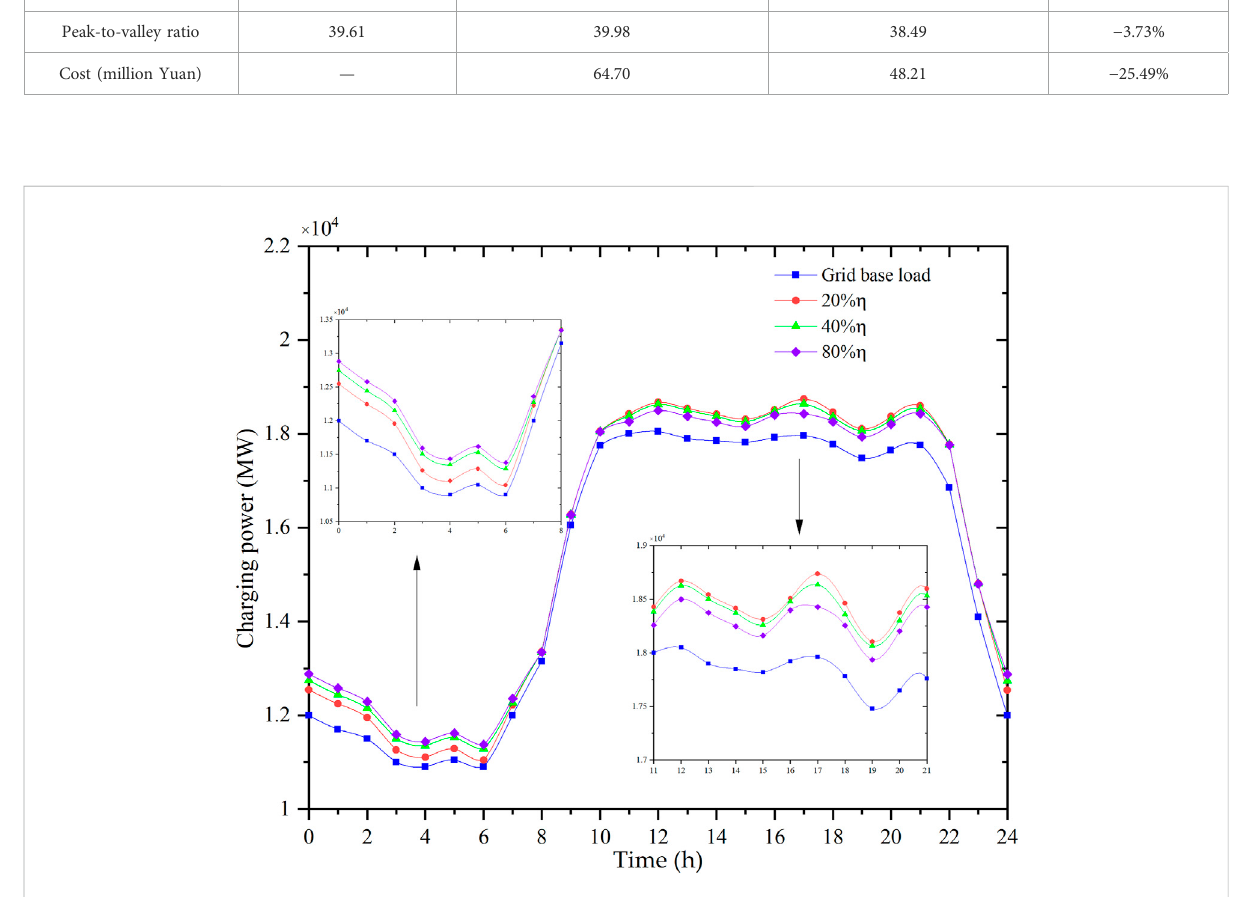
FIGURE 9 Sensitivity analysis of the participation